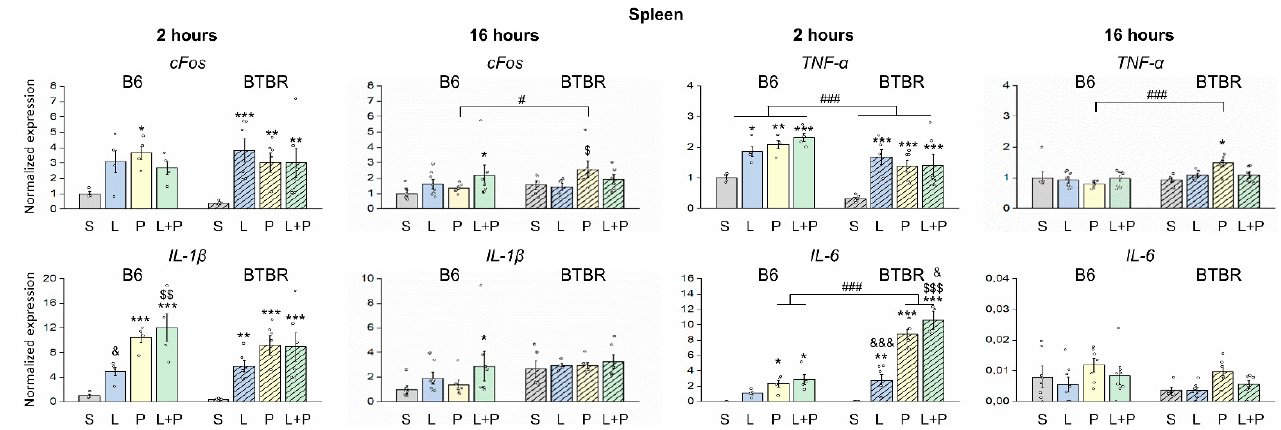
Figure 4. Changes in splenic levels of neuronal early response gene ( cFos) and cytokines’ mRNAs after the induction of inflammation via administration of polyI:C (P), LPS (L), or their combination (L+P). The control group is marked as S (received saline). The mRNAs were quantified by RT-PCR. Factorial ANOVA, mean ± SEM, n = 4–8 per group. * p < 0.05, ** p < 0.01, *** p < 0.001 as compared to saline control; $ p < 0.05, $$ p < 0.01, $$$ p < 0.001 compared to the LPS group; & p < 0.05, p < 0.01, &&& p < 0.001 as compared to the polyI:C group; # p < 0.05, ### p < 0.001 in comparison with the B6 strain according to Fisher’s LSD test as a post hoc analysis.